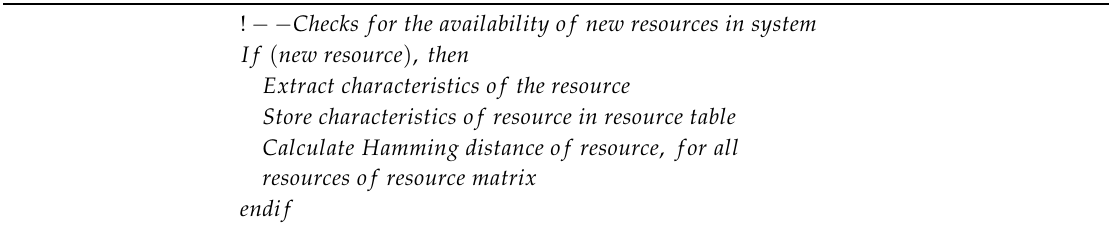
Algorithm A1: Algorithm for the verification of new resources in the